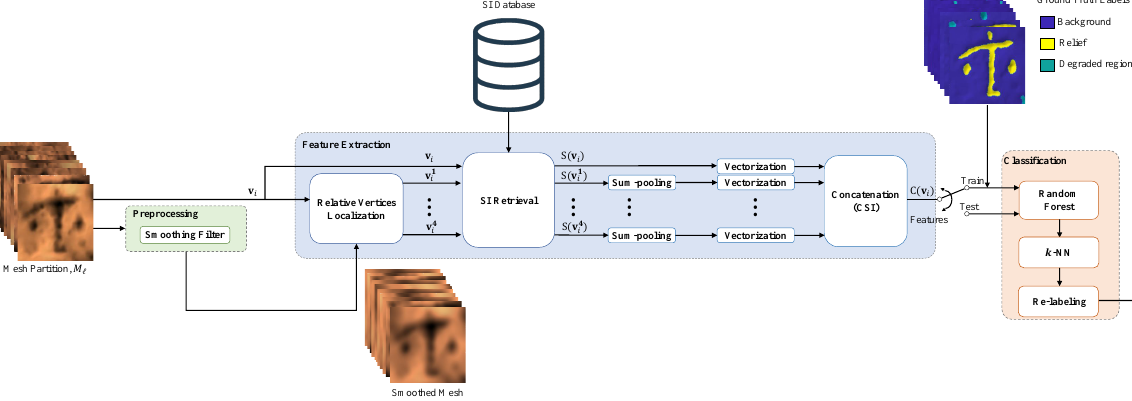
Figure 2. The proposed relief extraction method.